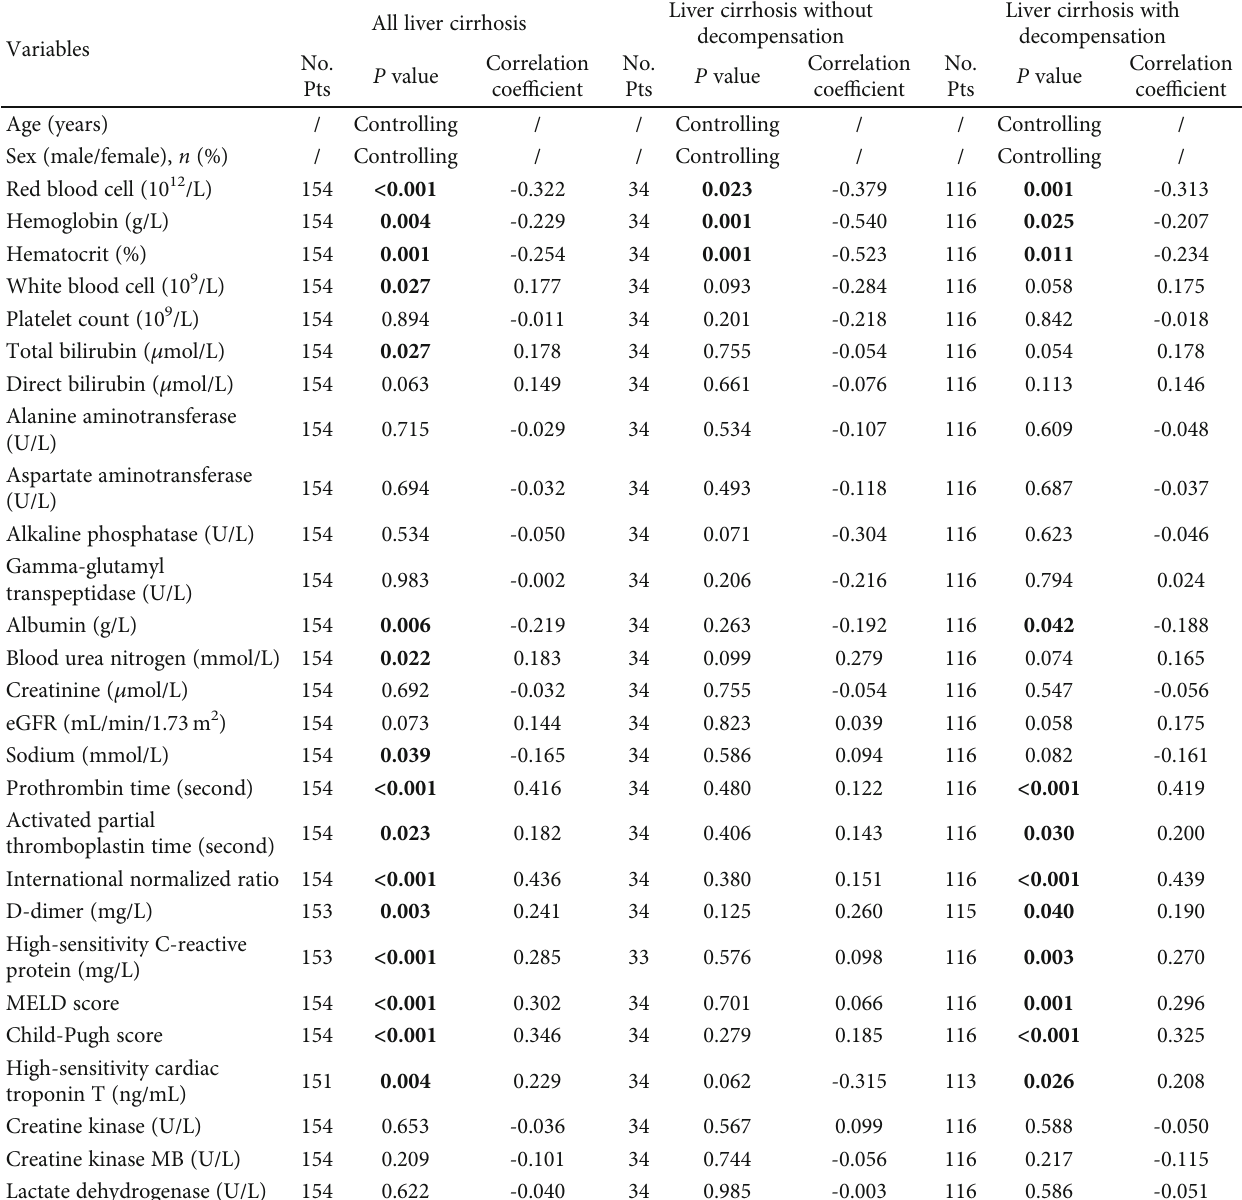
Table 3: Partial correlation analysis of the NT-pro BNP level in